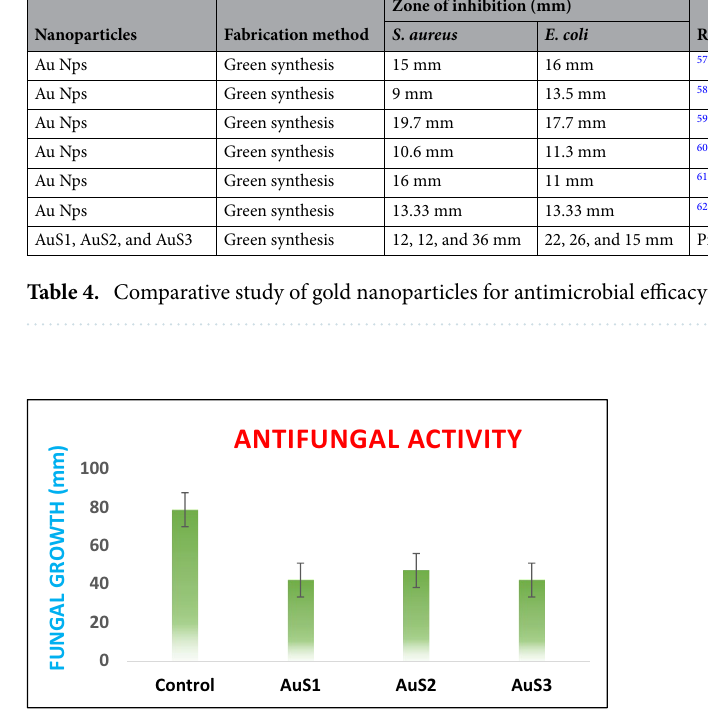
Figure 12. Fungal growth of selected fungal strains by synthesized gold nanoparticle.